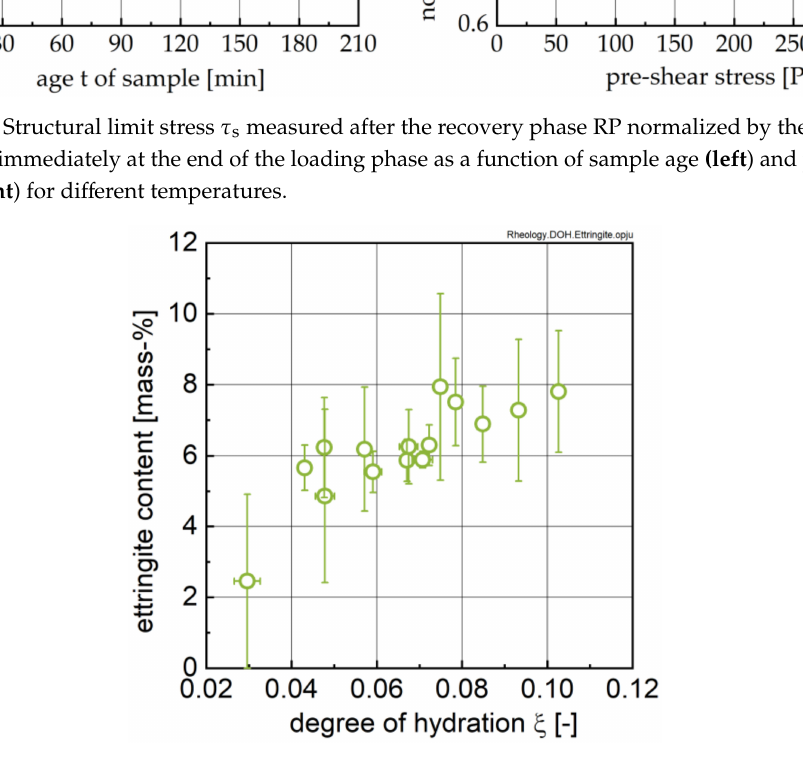
Figure 14. Ettringite content of investigated cement pastes determined via QXRD (see Figure 6) as a function of the degree of hydration calculated from calorimetry (see Figure